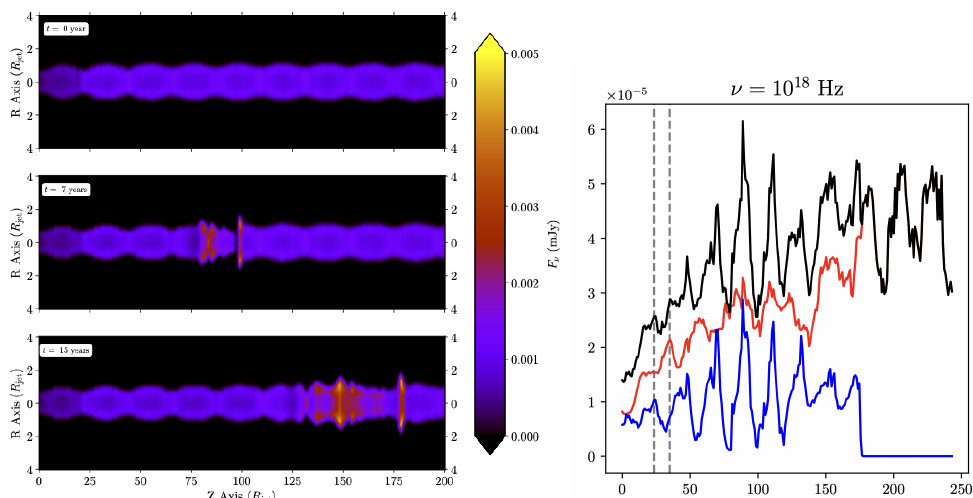
Figure 4. ( Left ): Synchrotron emission map at 10 10 Hz of an MHD simulation showing the impact of a fast ejecta propagating through a series of recollimation shocks in a relativistic jet, seen under 90 ◦ . The x - and y -axes are given in units of the jet-radius R jet . ( Right ): Light curve of the emission in the X-ray range showing the contribution from the ejecta (blue) and the remaining jet (red). The units on the X -axis are years in the observer frame (taken from [86]). Credit: [86], A&A, reproduced with permission